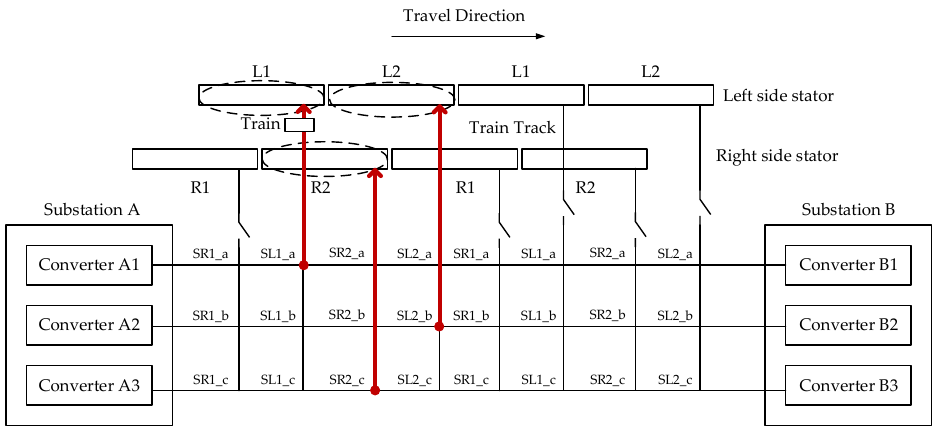
Figure 12. Demonstration of the switching process of the three-step method (Circumstance 2).